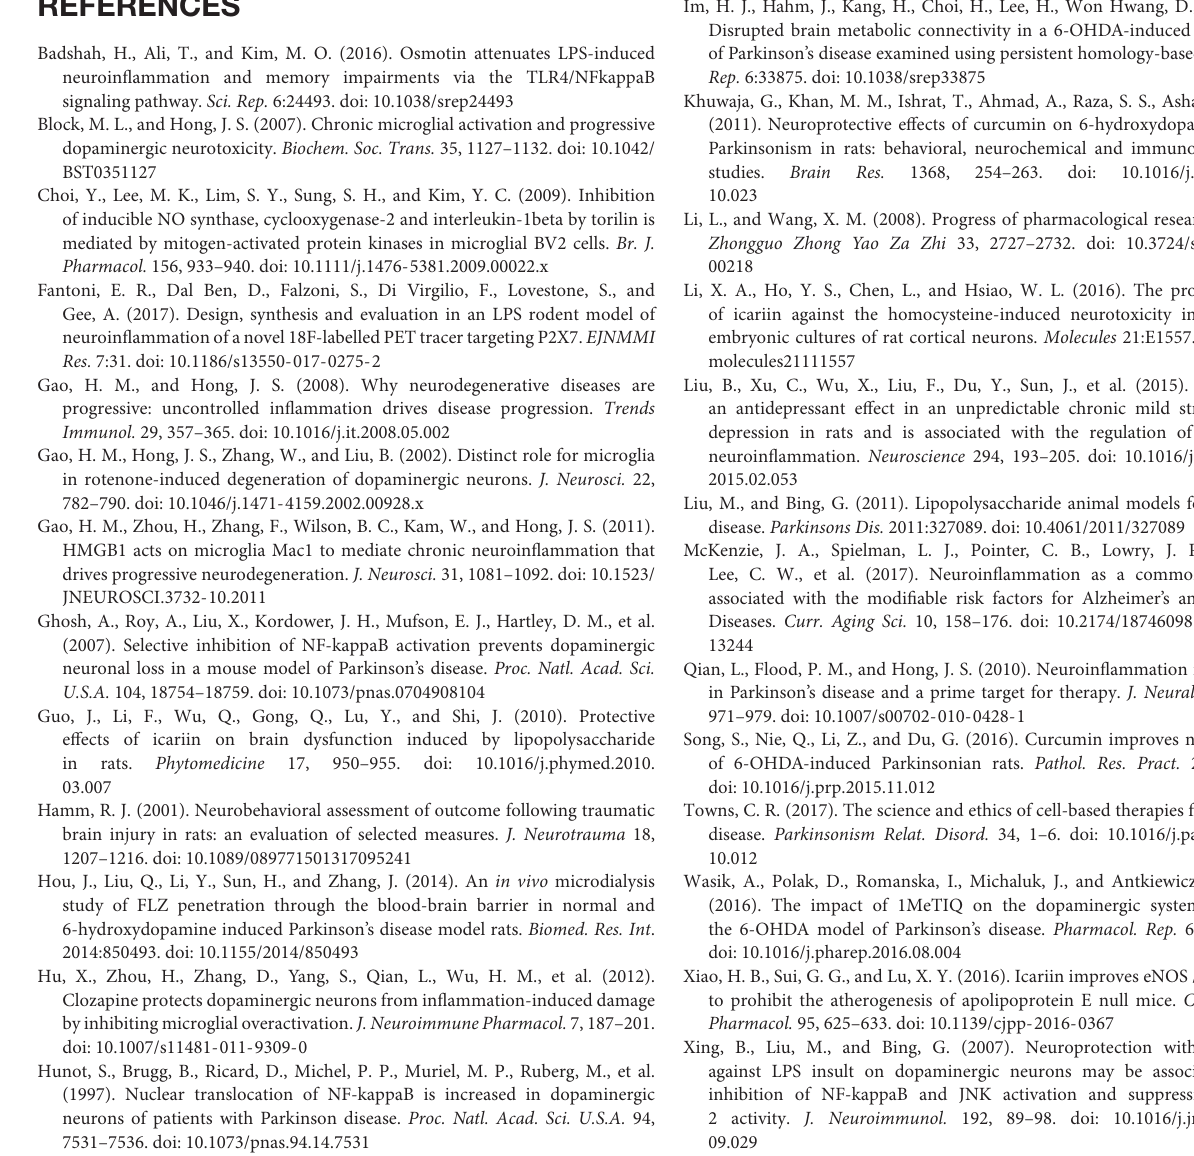
FIGURE S2 | Icariin ameliorated p65 phosphorylation induced by LPS and